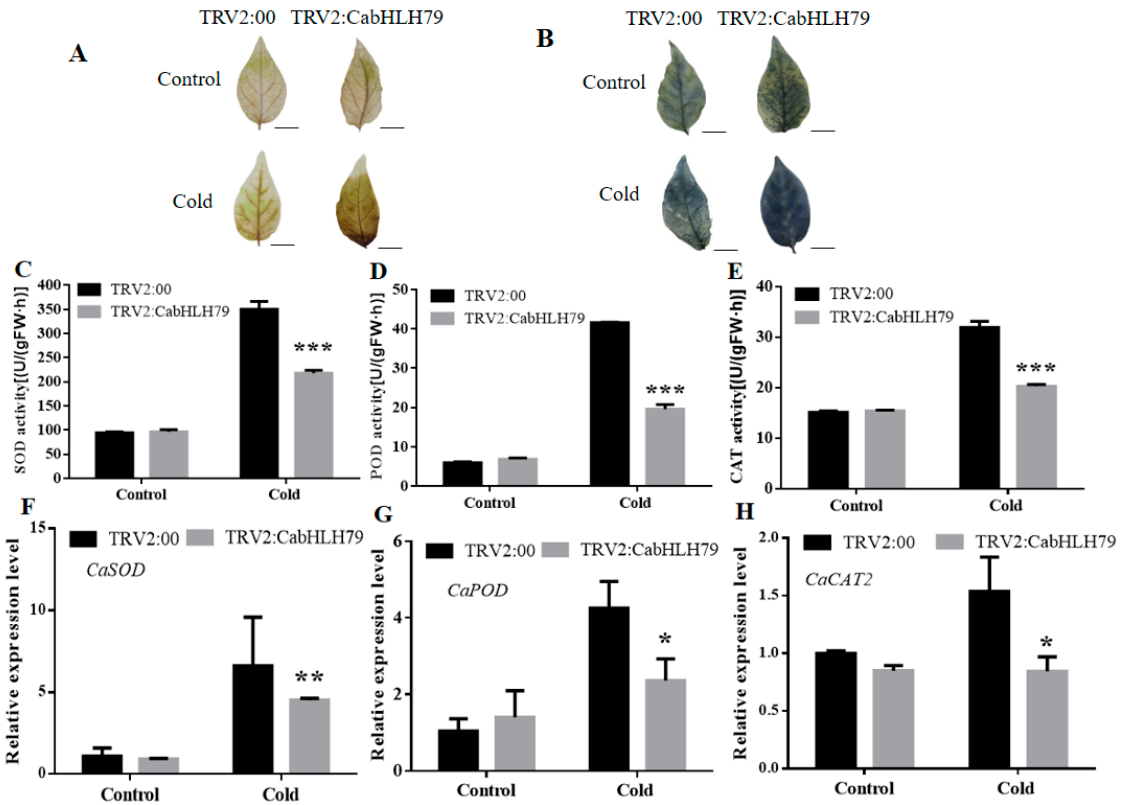
Figure 3. Reactive oxygen species (ROS) levels in CabHLH79 -silenced and control plants. ( A ) DAB staining. ( B ) NBT staining. The black line is used as a scale bar (length 1 cm). ( C ) SOD activity. ( D ) POD activity. ( E ) CAT activity. ( F – H ) RT-qPCR analysis of CaSOD , CaPOD , and CaCAT2 . All data of three independent biological replicates were expressed by Means ± SDs. * representing significant difference (* p < 0.05, ** p < 0.01, *** p < 0.001).